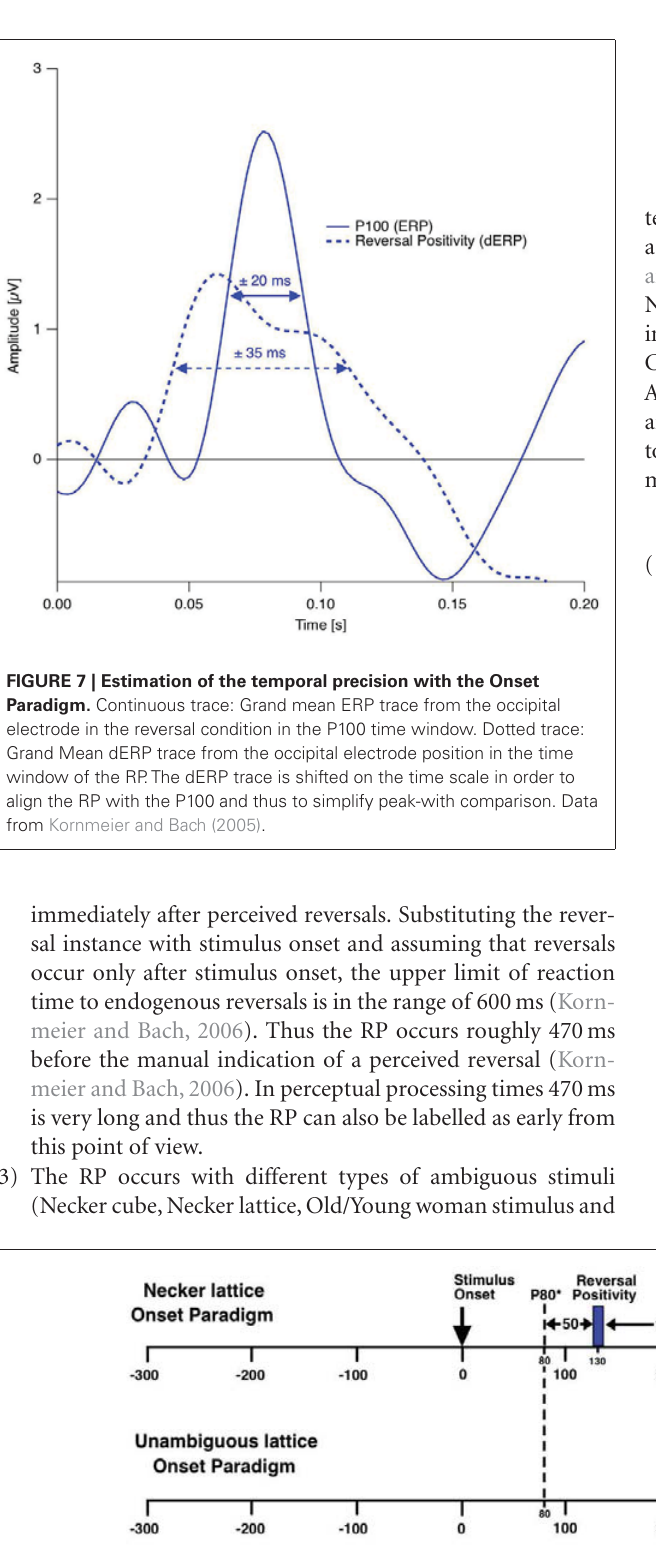
component before subtraction. Negative values on the time axis reflect the time period of the ISI before stimulus onset. Data from Kornmeier and Bach (2004b,